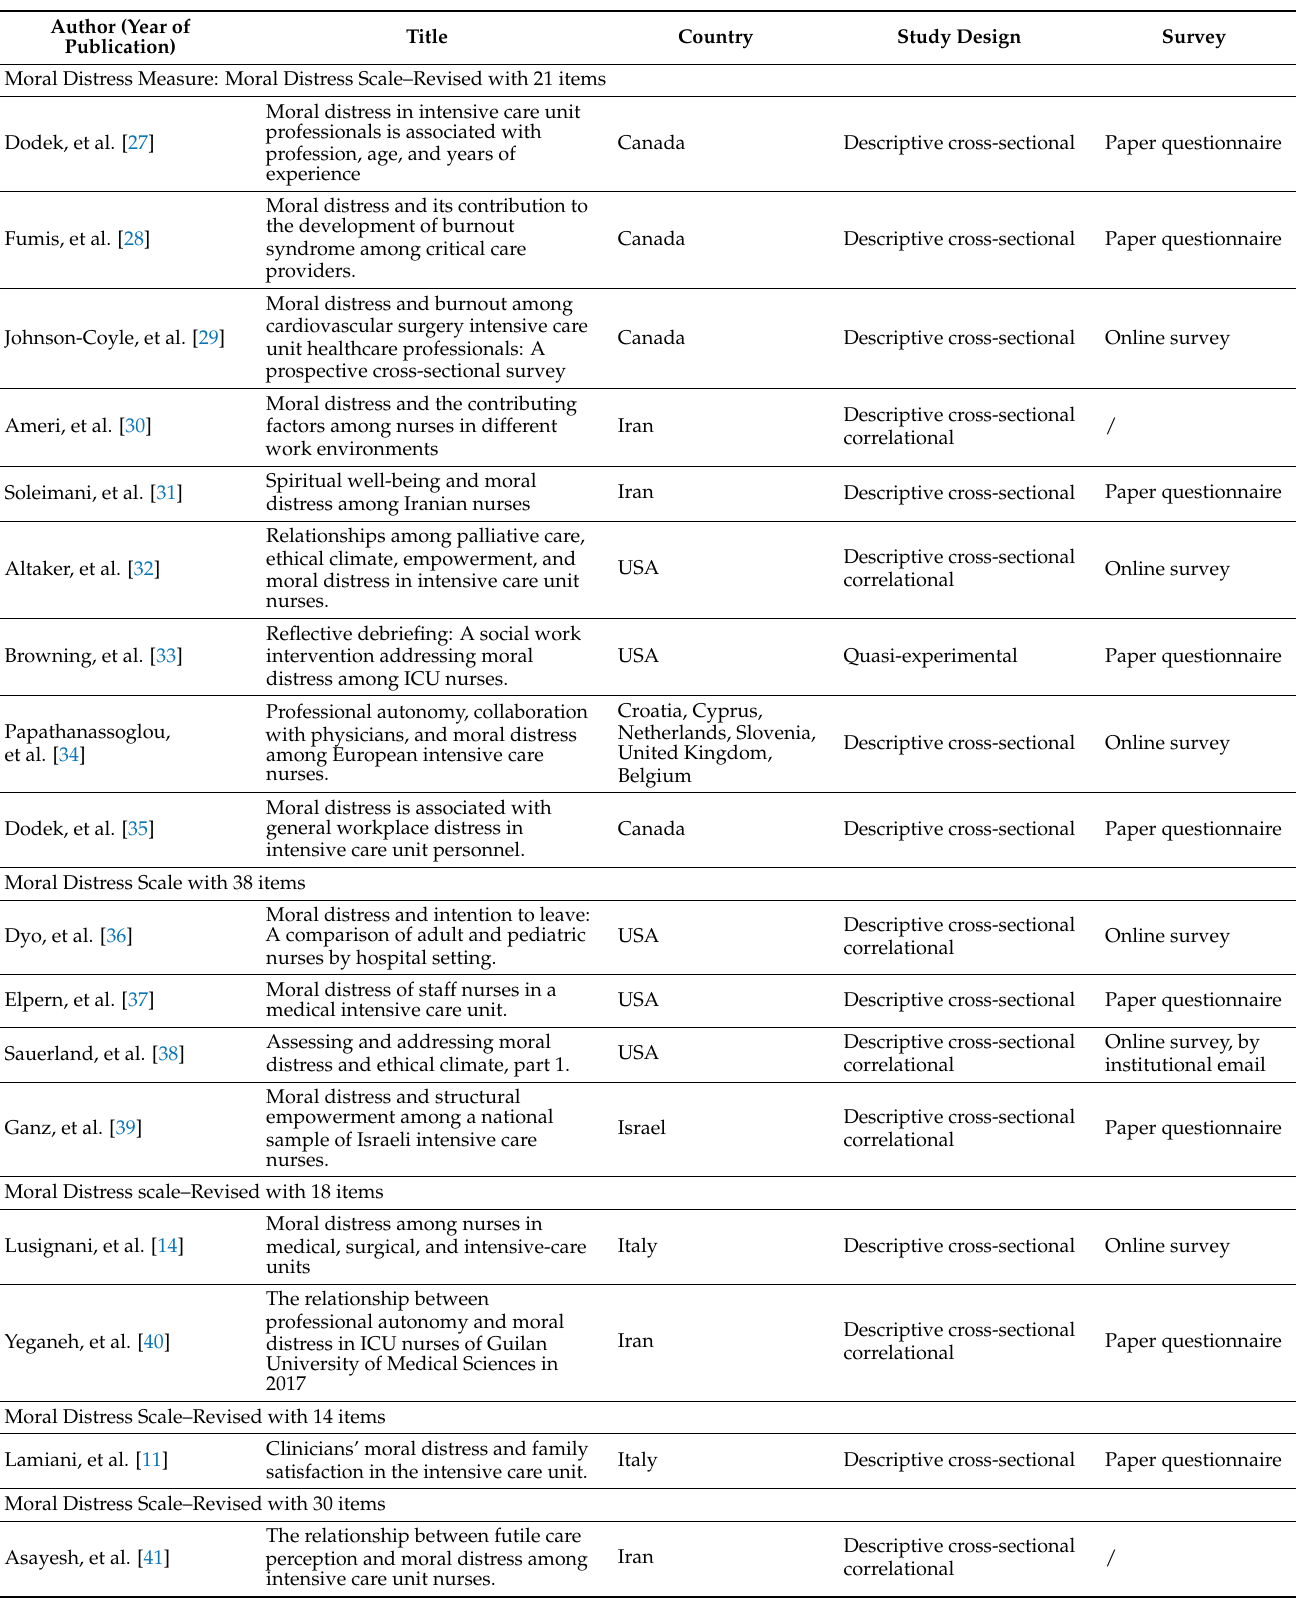
Table 2. Characteristics of included